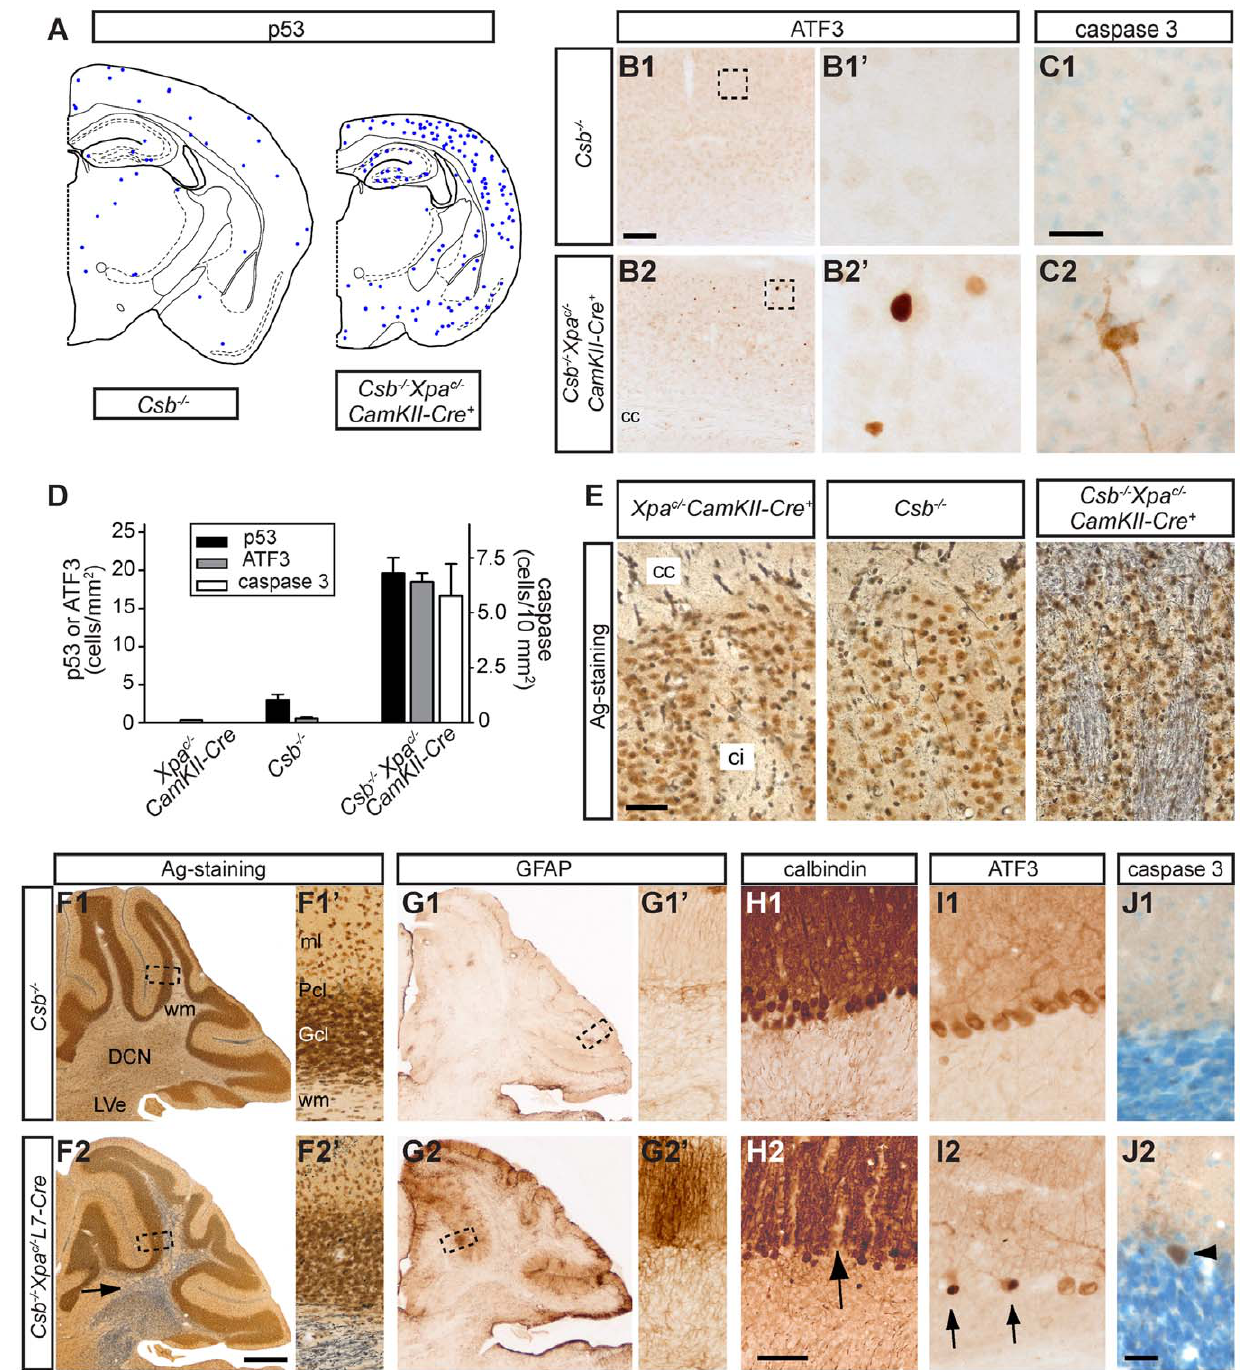
Figure 6. Neurodegenerative changes in forebrain neuron-specific and Purkinje cell-specific knockout of Xpa in Csb 2 / 2 mice. A–D) Neurolucida plot (A), representative photomicrographs (B, C) and bar graph (D) of p53 (A, D), ATF3 (B, D) and active caspase 3 (C, D) staining in the cortex of 65 week old Csb 2 / 2 and Csb 2 / 2 Xpa c/ 2 CamKII a -Cre mice showing an increase in the number of p53- and ATF3 immunoreactive cells and the appearance of caspase 3 labeled neurons in the cortex of Csb 2 / 2 Xpa c/ 2 CamKII a -Cre mice. Values in bar graph in d represent means 6 SE from 3 mice per group. E) Silver degeneration staining in the caudatus-putamen shows a high level of argyrophilic fibers in the capsula interna (ci) and corpus callosum (cc) of 16 month-old Csb 2 / 2 Xpa c/ 2 CamKII a -Cre mice while no stained fibers occurred in these fiber tracts in wild-type (not shown), Csb 2 / 2 and Xpa c/ 2 CamKII a -Cre mice. F–J) Photomicrographs of sagittal cerebellar sections of 25-week old Csb 2 / 2 (F1–J1) and Csb 2 / 2 Xpa c/ 2 L7-Cre mice (F2– J2). F) Silver degeneration staining shows a high level of argyrophilic fibers in the deep cerebellar nuclei (DCN) and the white matter (wm) of Csb 2 / 2 Xpa c/ 2 L7-Cre cerebellum (arrow in F2). G) GFAP-immunoperoxidase staining shows increased GFAP staining in the molecular (ml) and Purkinje cell (Pcl) layers Csb 2 / 2 Xpa c/ 2 L7-Cre cerebellar cortex, while no change occur in the granule cell layer (Gcl). H) Calbindin-immunoperoxidase staining reveals calbindin-negative regions in the molecular layer (arrow in H2) of Csb 2 / 2 Xpa c/ 2 L7-Cre cerebellar cortex. I) A number of Purkinje cells showed strong nuclear ATF3 staining (arrow in I2). Note that the ATF3 antibody also outlines Purkinje cells because of non-specific cytoplasmatic staining of